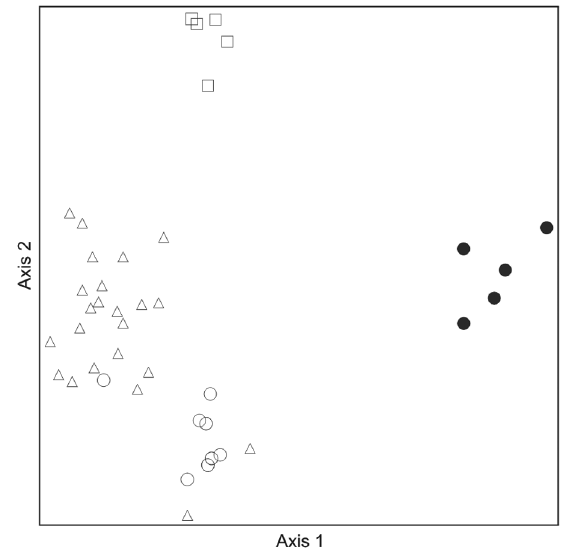
Figure 4 - Two-dimensional plots ordination diagram derived from DCA for arboreal sinusiae along a soil moisture and fl ood gradient in RPPN SESC Pantanal, Brazilian Pantanal. ∆ - Dry Forests facies; ○ - Cerradão de Carvoeiro facies (Savanna Forest); □ - Cerrado de Lixeira (Open Low-tree Savanna); ● - Cambarazal (Seasonally Flooded Semi Evergreen